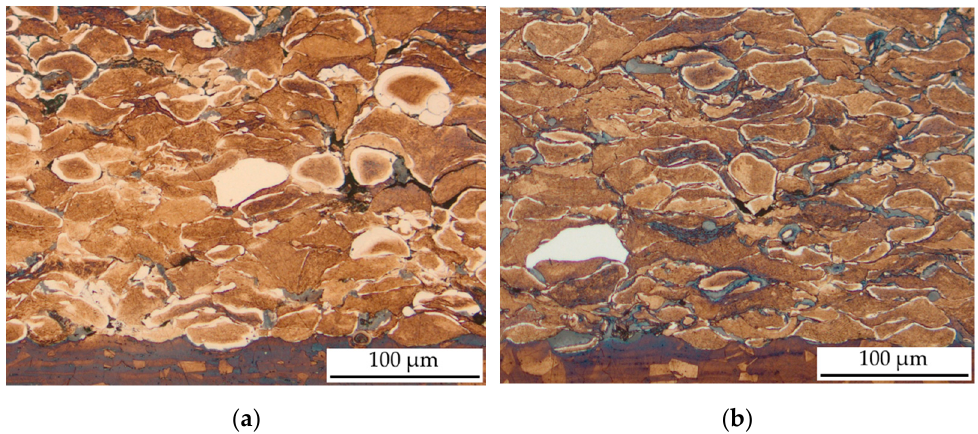
Figure 3. Optical-microscopic image of a Beraha-II-etched AISI 316L CGS coating using ( a ) 850 °C and 40 bar and ( b ) 1100 °C and 50 bar with 25% He in cross-section.